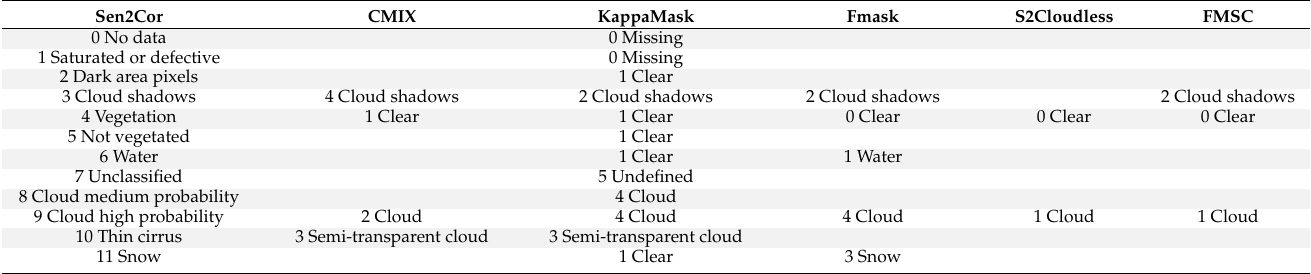
Table 1. Output correspondence for different cloud classification masks. KappaMask output scheme is used for model fitting with logic corresponded to CMIX notation. Sen2Cor, Fmask, MAJA and S2cloudless are mapped respectively to KappaMask output. FMSC to Francis, Mrziglod and Sidiropoulos’ classification map [27] is used for pretraining. Sen2Cor CMIX KappaMask Fmask